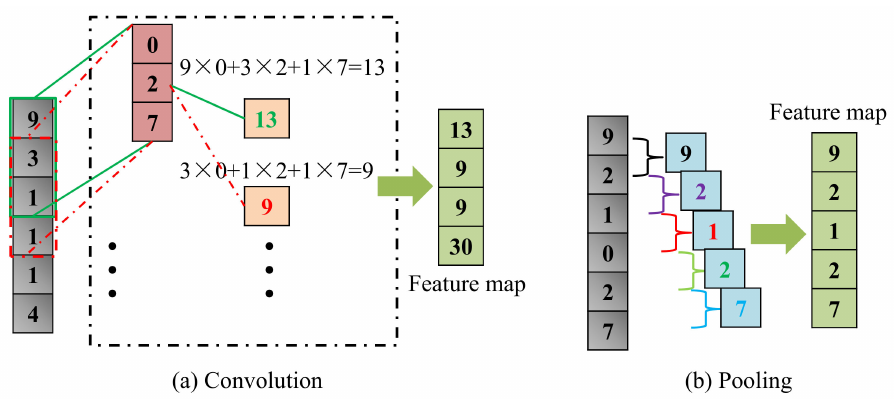
Figure 7. Convolution and pooling operations. ( a ) Convolution; ( b )